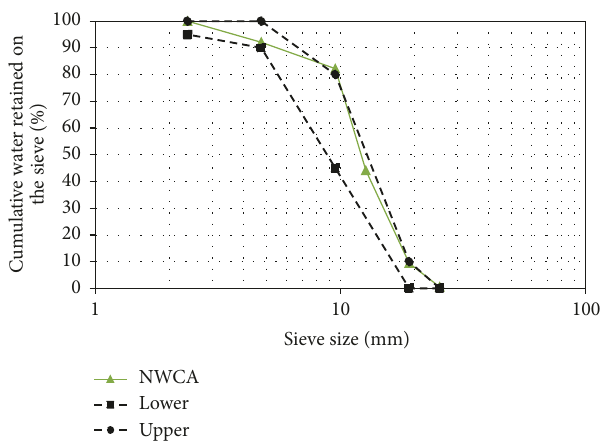
Figure 3: Size distribution of normal weight coarse aggregates (NWCA) used in accordance with ASTM C33 Size Number